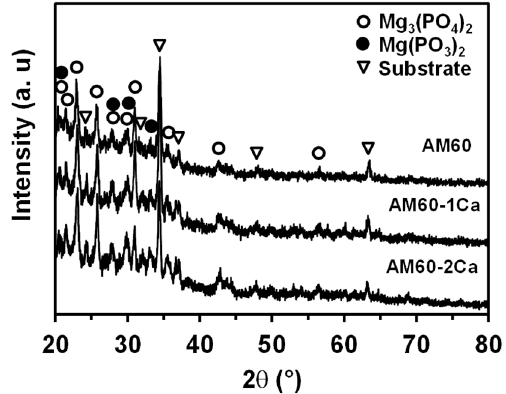
Figure 6. XRD patterns of the plasma electrolytic oxidation (PEO) film formed AM60, AM60-1Ca, and AM60-2Ca specimens for 20 min anodization in 0.5 mol·dm − 3 Na 3 PO 4 solution at 25 °C.